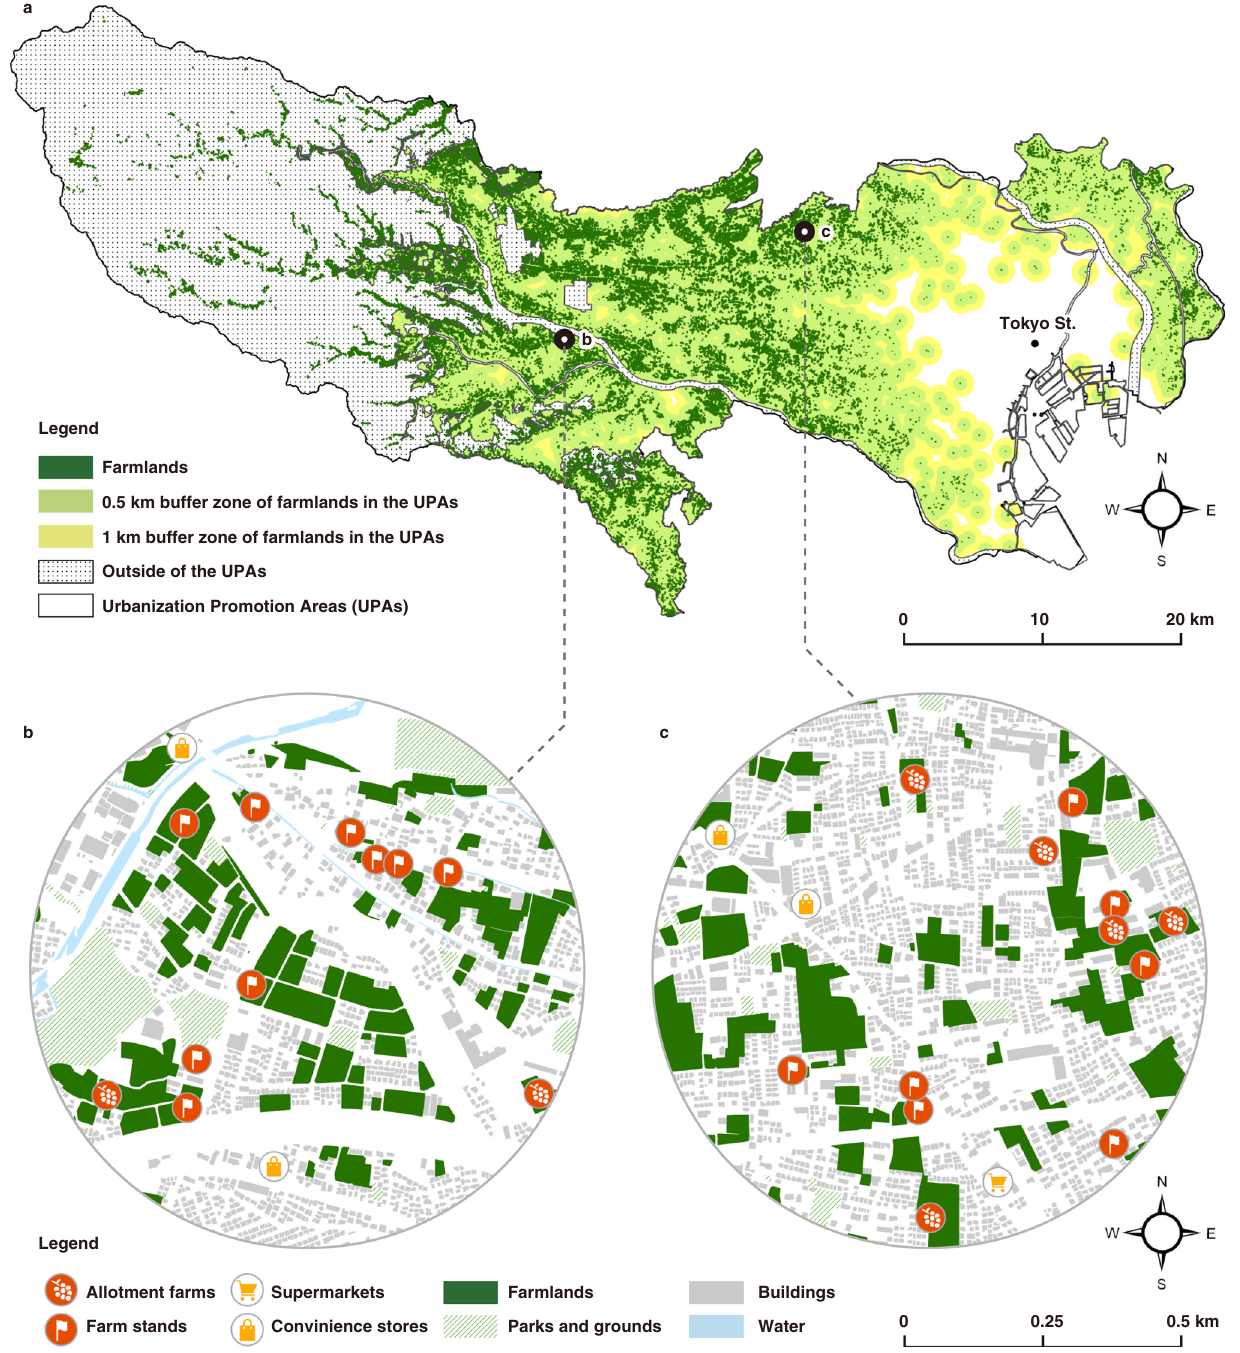
Fig. 1 Urban farmlands in Tokyo. a Farmlands and their buffer zones of 0.5 and 1 km radiuses in the urbanization promotion areas (UPAs). b , c Close-up maps of the 0.5 km radius areas indicated by the black line circles on Map a . These maps show examples of residential neighborhoods with a mixture of agricultural land in Hino City ( b ) and Nerima Ward ( c ). Residents can access allotment farms and farm stands within walkable distances (Map a excludes the islands in